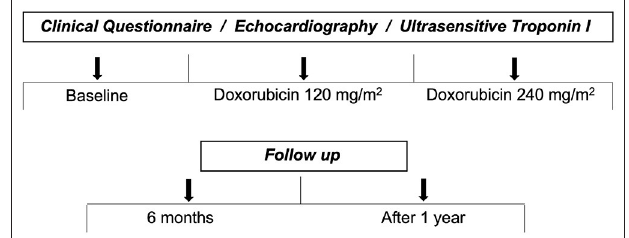
FIGURE 1 | Stages of